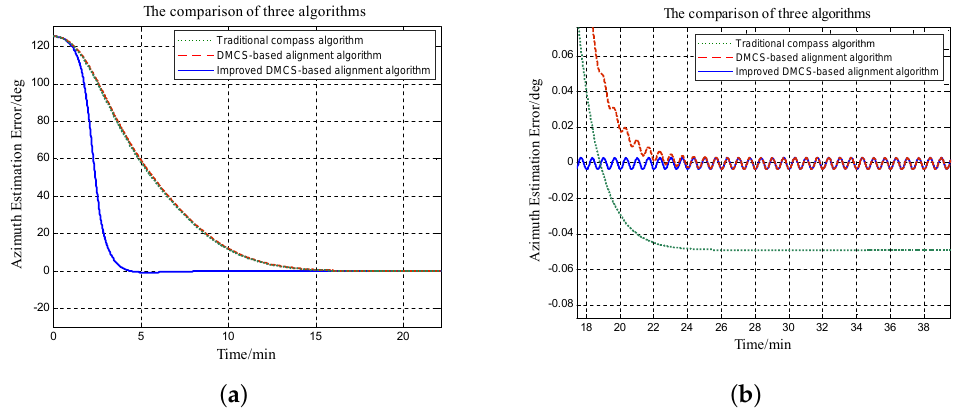
Figure 12. Error curves of the azimuth misalignment angle by utilizing three different initial alignment methods when the initial azimuth misalignment angle is 125 ◦ . The green dotted line denotes the initial alignment algorithm based on the traditional compass method; the red dashed line denotes the error curve with the initial alignment algorithm based on the DMCS method; the blue solid line denotes the error curve with the improved DMCS-based initial alignment algorithm. ( a ) Errors of the azimuth misalignment angle. ( b ) Magnification of azimuth misalignment angle